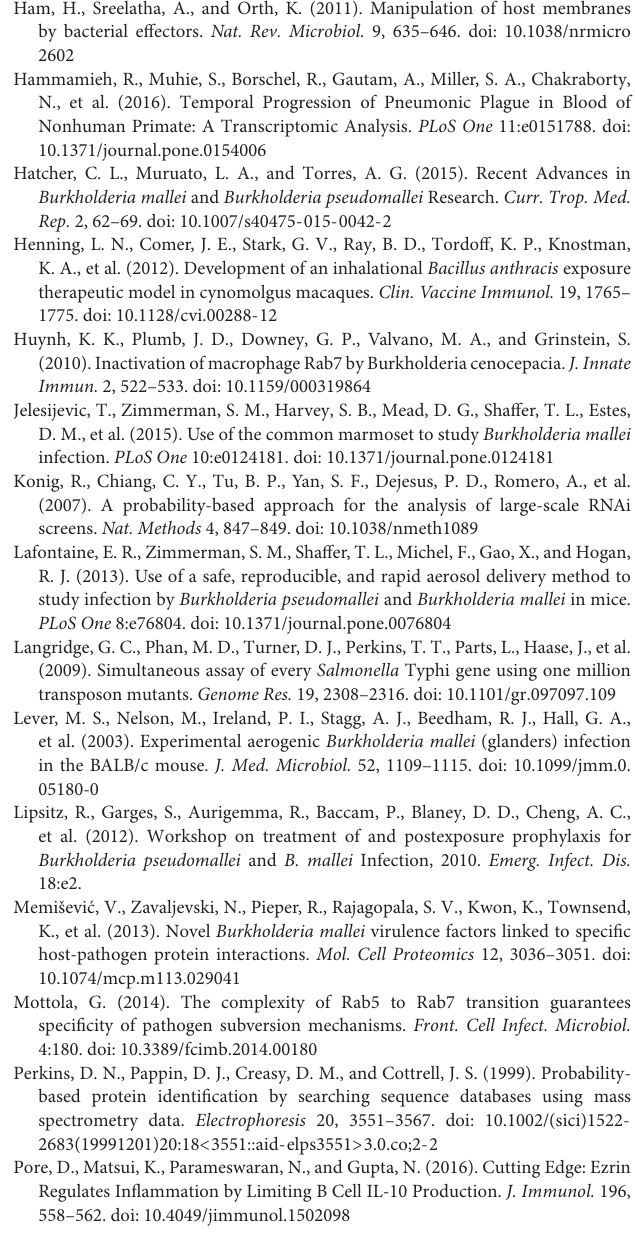
Supplementary Table 3 | Hierarchical clustering of the proteomic data. Tab “Data” is the underlying data for Figure 2 . African Green monkey (AGM), cynomolgus macaques (CM) and rhesus macaques (RM). Supplementary Table 4 | Gene ontology (GO) analyses of 86 host factors that are differentially expressed in B. mallei infected rhesus macaques. Tab “Data” is the underlying data for Figure 2B . Supplementary Table 5 | The underlying data of the Circo plot and share GO terms for Figure 2C . Supplementary Table 6 | The mass spectrometry proteomics data has been deposited to the ProteomeXchange Consortium via the PRIDE partner repository. The dataset identifiers are listed in the